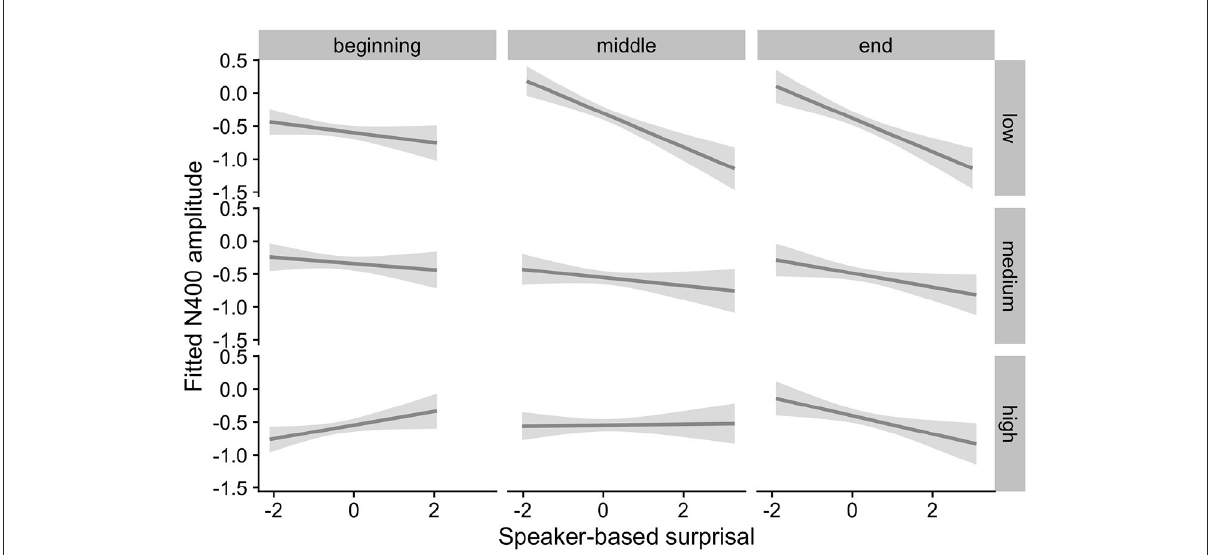
FIGURE6 Effect of idea density (ID) on changes in the relationship between speaker-based surprisal (z-transformed) and N400 amplitude over the course of Experiment 1. The figure visualizes partial effects as calculated using the remef package, adjusted for prestimulus amplitude and canonicity. Note that position in the experiment (operationalised via epoch in the statistical model) is trichotomised into thirds (beginning, middle, end) for visualization purposes only; epoch was included in the model as a continuous predictor. The same holds for ID, which is trichotomised into low, medium and high for visualization purposes but was entered into the statistical model as a continuous predictor. Shaded areas indicate 95% confidence